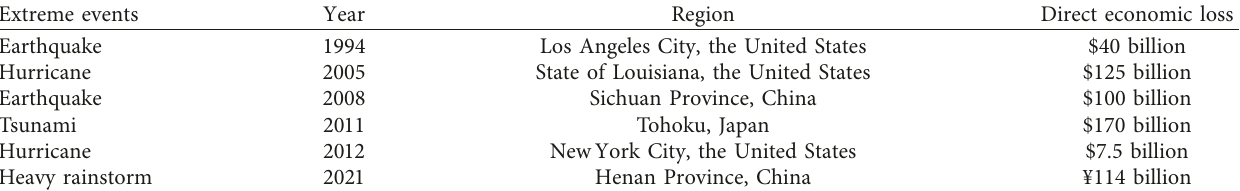
Table 1: Consequences associated with extreme